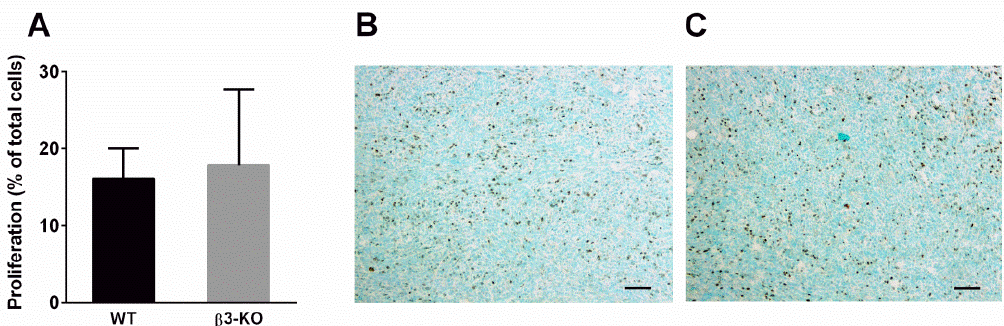
Figure 3. Percentage of proliferating cells of total cells was calculated using immunohistochemical detection of Ki67 in 4T1 ( n = 4) tumors ( A ) obtained from WT and β3-KO mice. No statistical difference was found ( p = 0.76). Mean ± SD. Representative images from both genotypes are shown ( B , C ). Scale bars indicate 100 µm.